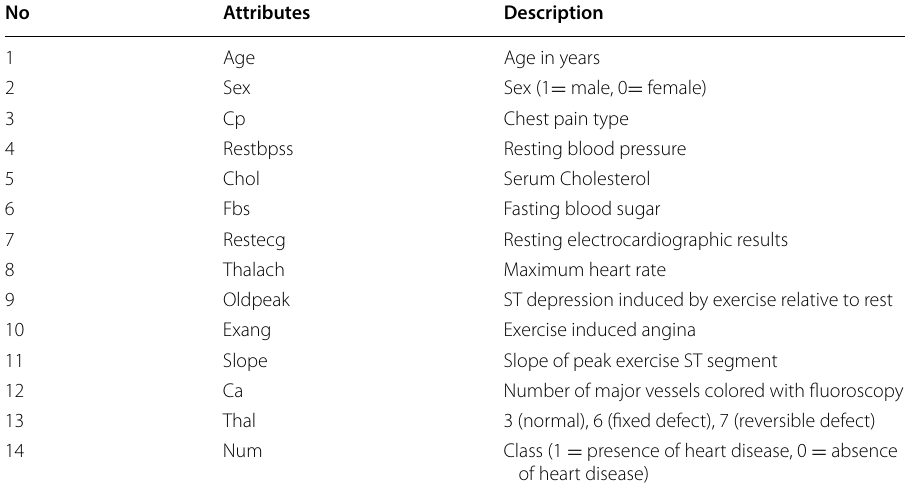
Table 2 Heart disease dataset attributes description